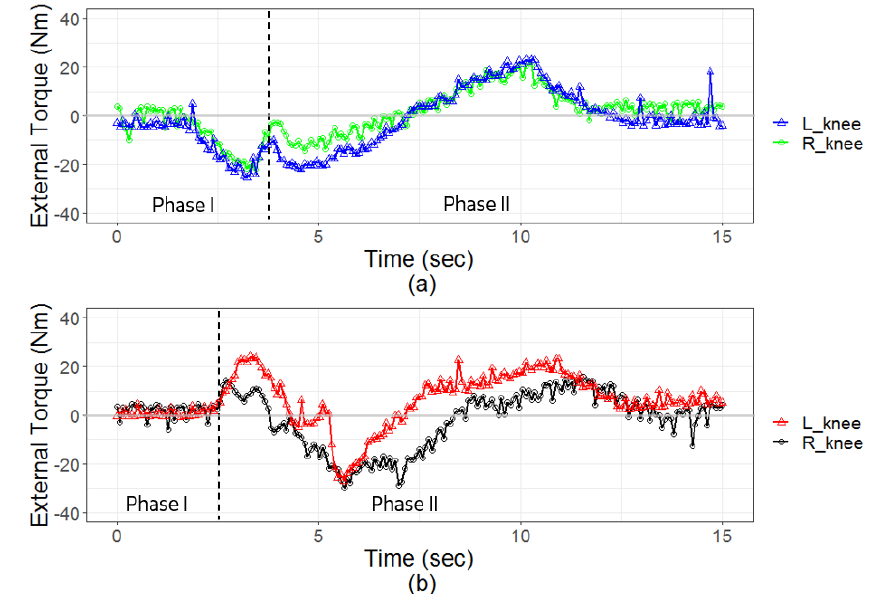
Figure 12. External torque measured from the knee joint using the correct ( a ) and incorrect ( b ) meth- ods of standing assistance.